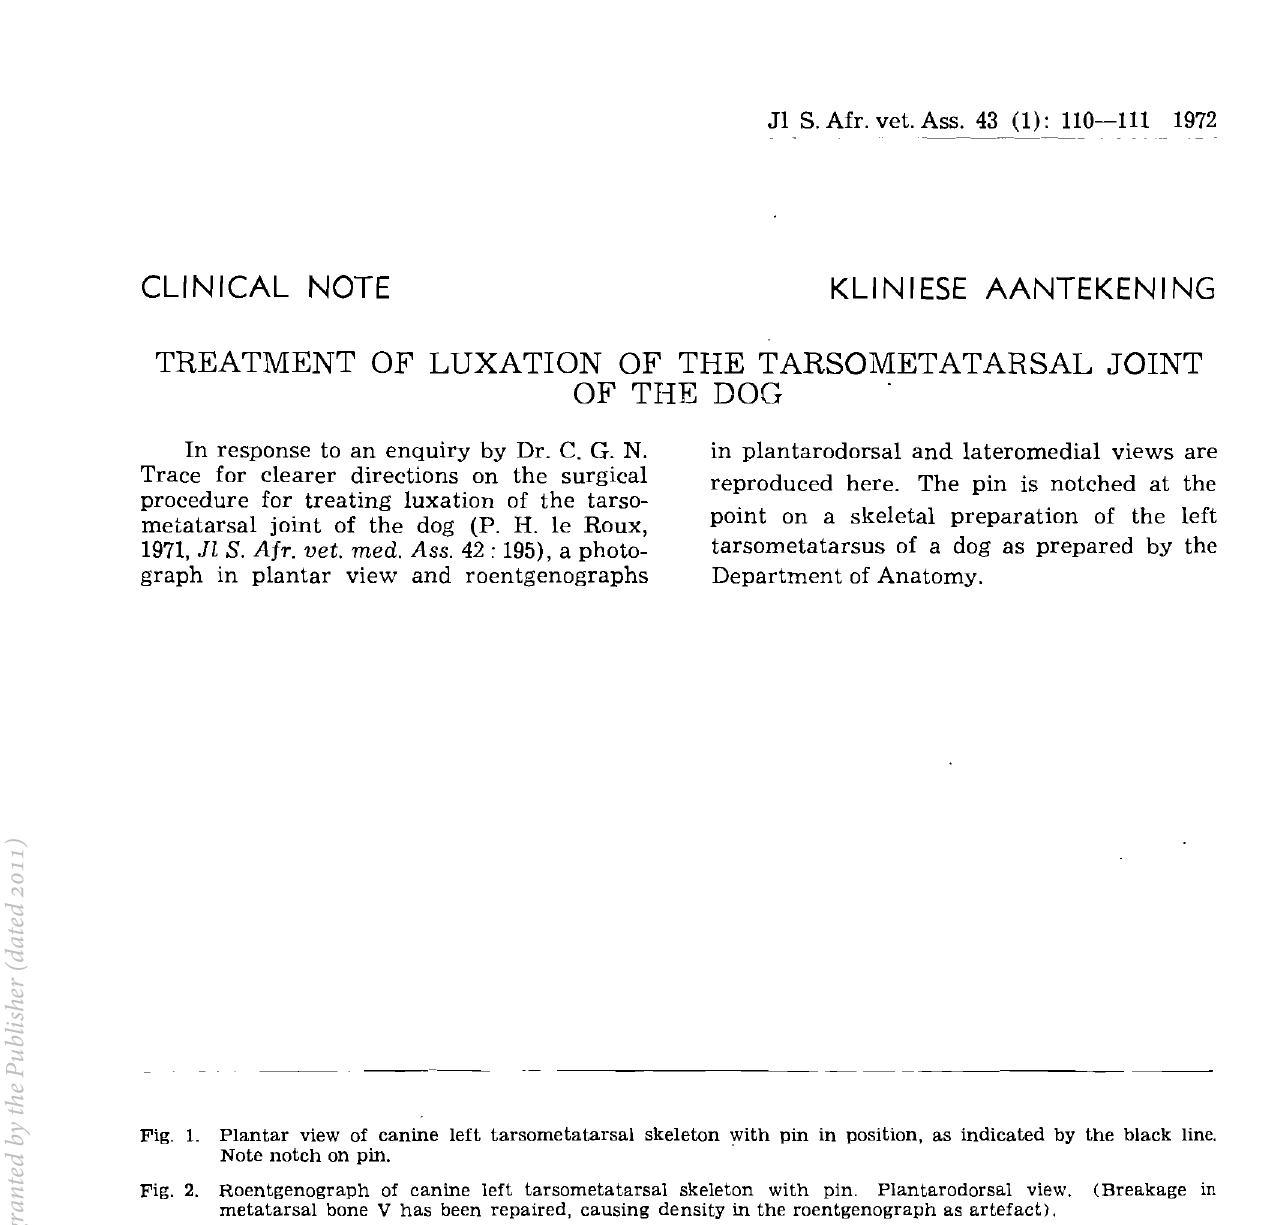
Fig. 1. Plantar view of canine left tarsometatarsal skeleton with pin in position, as indicated by the black line. Note notch on pin. . Fig. 2. Roentgenograph of canine left tarsometatarsal skeleton with pin. Plantarodorsal view. (Breakage in metatarsal bone V has been repaired, causing density in the roentgenograph as artefact). Fig. 3. Roentgenograph of canine left tarsometatarsal skeleton with pin. Lateromedial